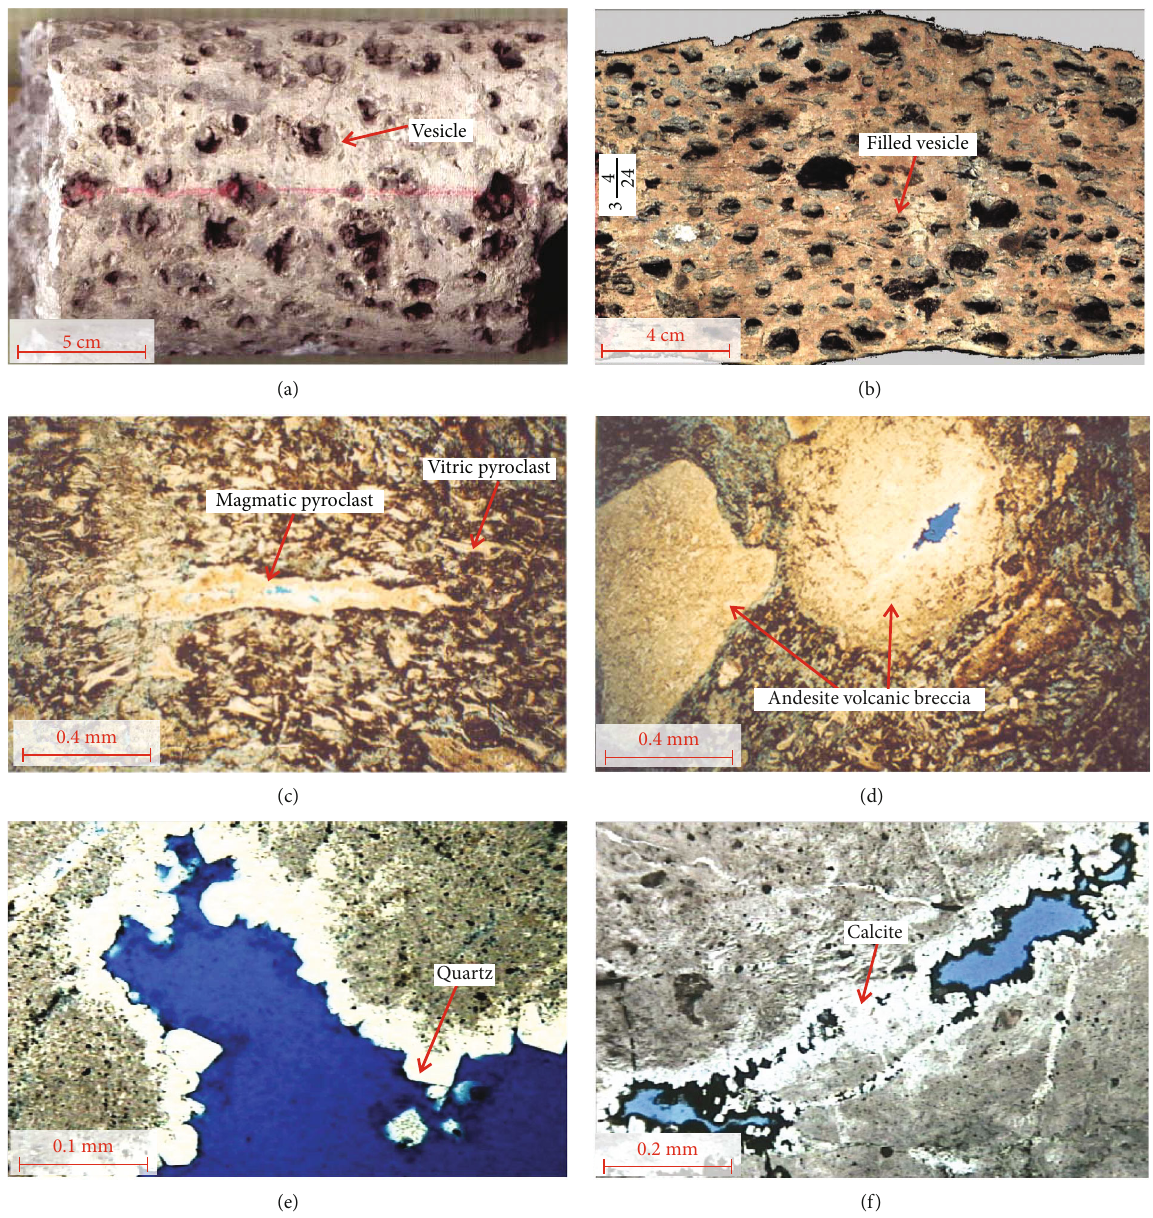
Figure 2: (a) Well X72, 4814 m, rhyolitic fused breccia tu ff with stoma development, × 20, lithology photo. (b) Well X201, 4932.56m, the rock is mainly composed of volcanic breccia, vitric pyroclast, and tu ff aceous matters, the volcanic breccia is composed of felsite and tu ff , and the stomas are partially fi lled, × 20, lithology photo. The rock around the vesicles displays fl uorescence. (c) Well X202, 4824.11m, felsite rock debris, magmatic pyroclasts and vitric pyroclasts can be seen, × 40, casting thin section. (d) Well X202, 4824m, vitric pyroclast tu ff aceous structure, andesite volcanic breccia can be seen, × 40, casting thin section. (e) Well X72, 4808.62m, quartz particles can be seen at the edges of vesicles, × 40, casting thin section. (f) Well X201, 4933.21m, vesicles are fi lled with quartz or calcite, × 25, casting thin